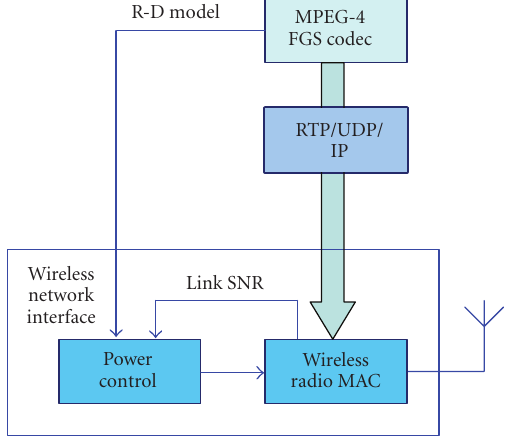
Figure 2: Block diagram of the main components at the mobile terminal